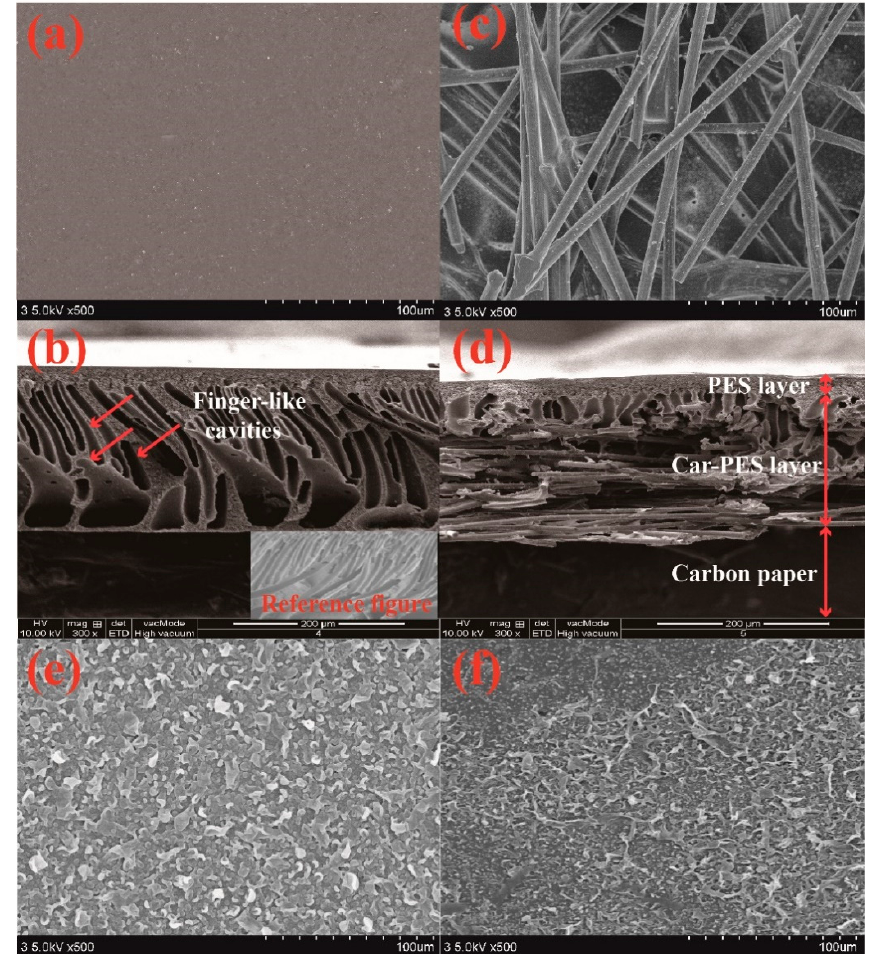
Figure2. SEMimagesofthebottom, cross-sectionsandtopofPES( a , b , e )andCar-PES( c , d , f )membranes: Figure 2. SEM images of the bottom, cross-sections and top of PES ( a , b , e ) and Car-PES ( c , d , f ) ( a , c ) bottom surfaces, ( b , d ) cross-sections and ( e , f ) top membranes: ( a , c ) bottom surfaces, ( b , d ) cross-sections and ( e , f ) top surfaces.